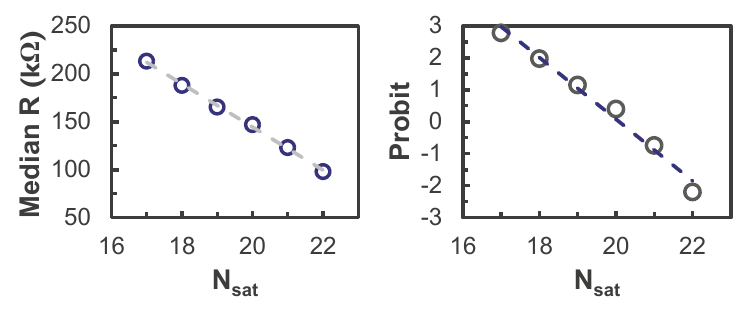
Figure 13: The median of the HRS distributions starting from different N sat values. The right figure shows the corresponding probability to find an N sat in an array, which is mapped by the real measurement data.